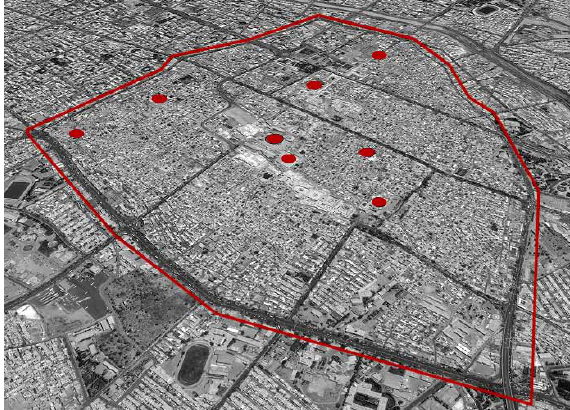
fig. 11. Some mosques of Shiraz historical neighbourhoods (created by the author according to Google Earth Map)